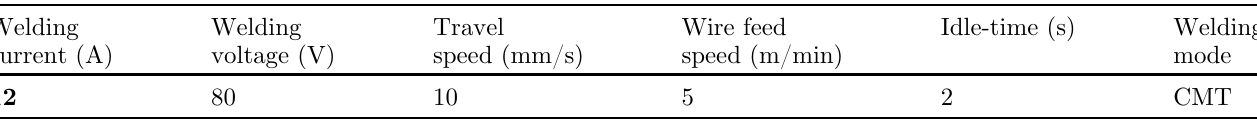
Table 1. Welding parameters for model validation.